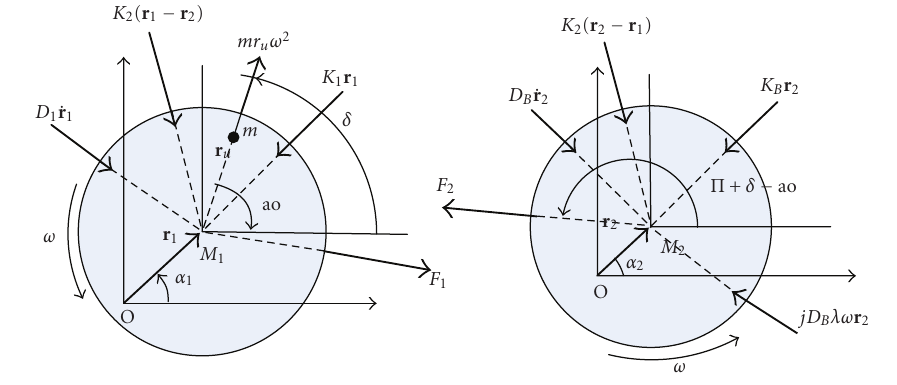
Figure 2: Lumped parameter modeling of forces in each plane.